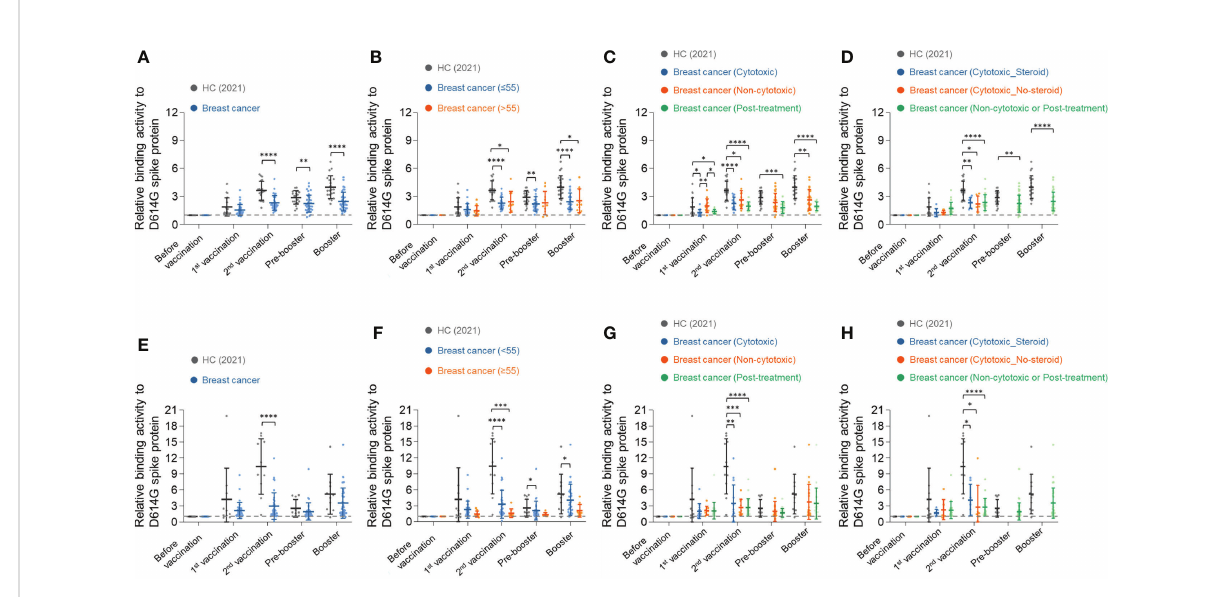
FIGURE 2 Longitudinal humoral immune responses to SARS-CoV-2 spike D614G protein in breast cancer patients. (A) Serum IgG binding activities to SARS-CoV-2 spike D614G in healthy control group and breast cancer patients group were determined using anti-IgG antibodies. The diluted serum samples (1:10) were incubated with SARS-CoV-2 spike D614G protein and then detected by streptavidin-HRP. (B – D) Breast cancer patients were strati fi ed by their age (B) , types of anti-cancer therapy (C) , and use of adjunct steroids (D) . (E – H) Serum IgA binding activities to SARS-CoV-2 spike D614G in the healthy control group and breast cancer patients group were determined using anti-IgA antibodies. (F – H) Breast cancer patients were strati fi ed by their age (F) , types of anti-cancer therapy (G) , and use of adjunct steroids (H) . Statistical analyses were performed using the Multiple unpaired T-test in GraphPad Prism (* P < 0.05, ** P < 0.01, *** P < 0.001, **** P <